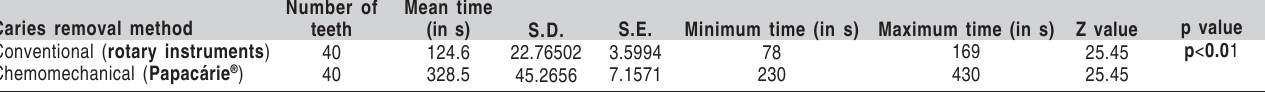
Data were analyzed statistically using the Z-test for time and pain assessment at 1% level of significance and paired t test for microbiological evaluation at 1% level of significance.